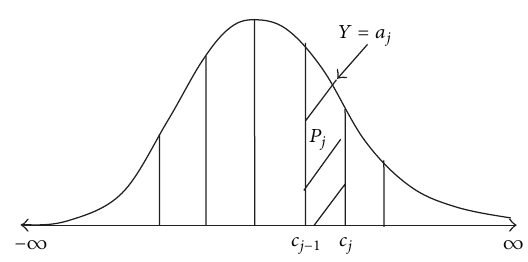
Figure 2: The plot of assigned score 𝑎 𝑗 and underlying latent